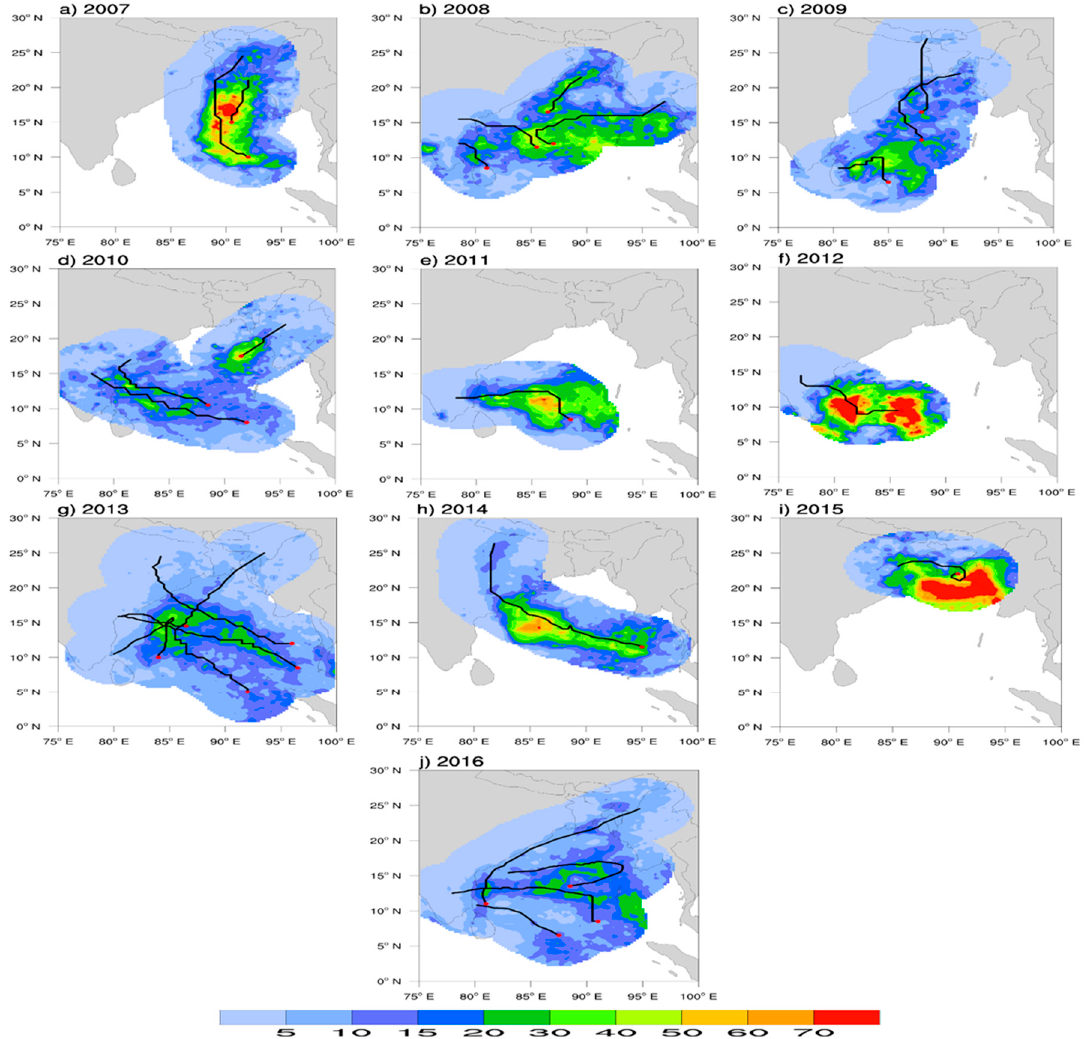
Figure 5. Same as Figure 4 but for 2007–2016. ( a ) 2007, ( b ) 2008, ( c ) 2009, ( d ) 2010, ( e ) 2011, ( f ) 2012, ( g ) 2013, ( h ) 2014, ( i ) 2015, ( j ) 2016.